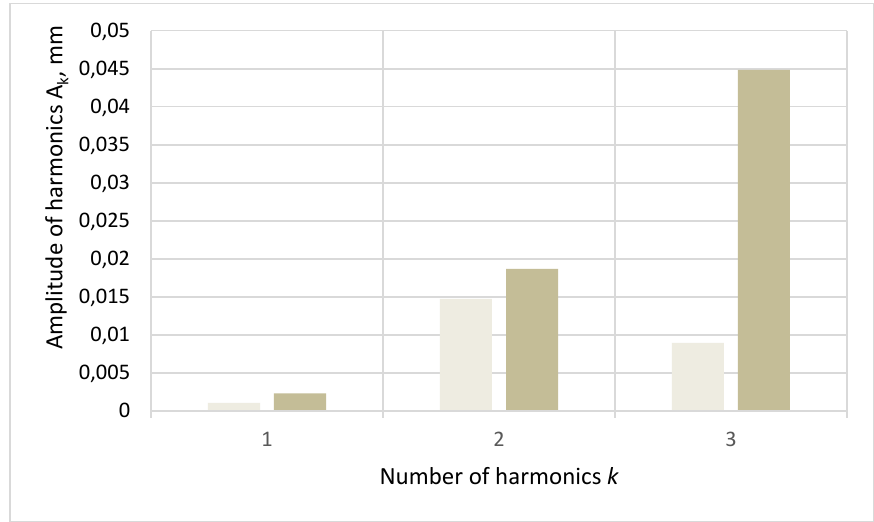
Fig. 8. Amplitudes of harmonics of the part thickness in the circumferential direction at a distance of 27 (light) and 32 (dark) mm from the